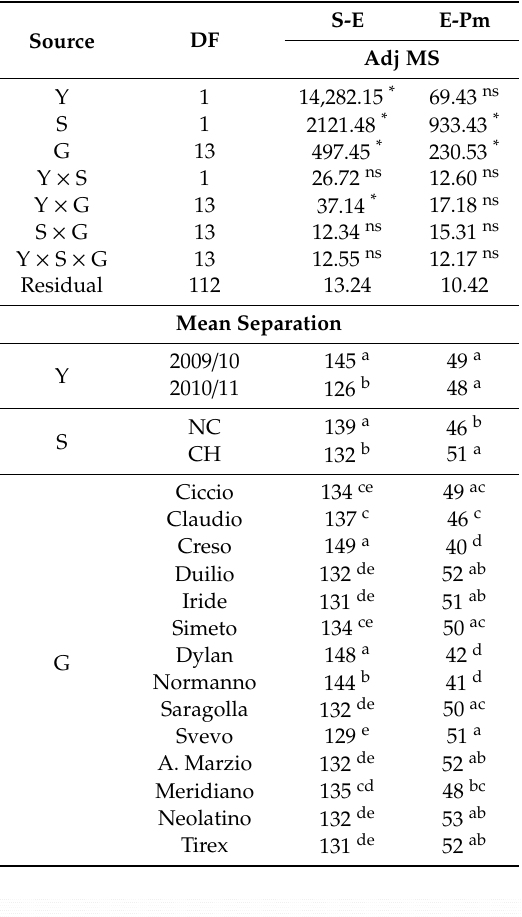
Table 2. ANOVA for main phenological phases (sowing-earing, S-E and earing-physiological maturity, E-Pm) of durum wheat genotypes (G) grown under two management systems (S) in two growing seasons (Y). Degree of freedom (DF); adjusted mean square (Adj MS); and significant per p ≤ 0.05 (*), Not significant (ns). Di ff erent letters within columns stand for significant mean according to the Student-Newman-Keuls (SNK) test ( p ≤ 0.05).